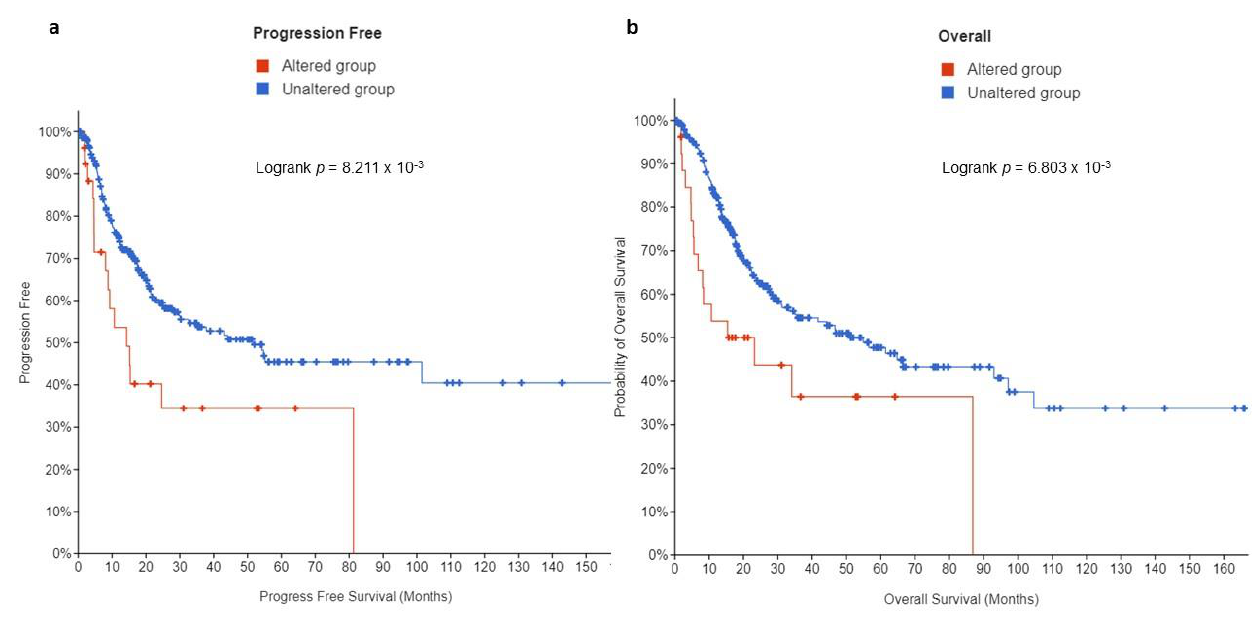
Figure 5. Kaplan Meier plots for ( a ) PFS and ( b ) OS in muscle-invasive UC patients from the MSK/TCGA 2020 cohort ( n = 476).